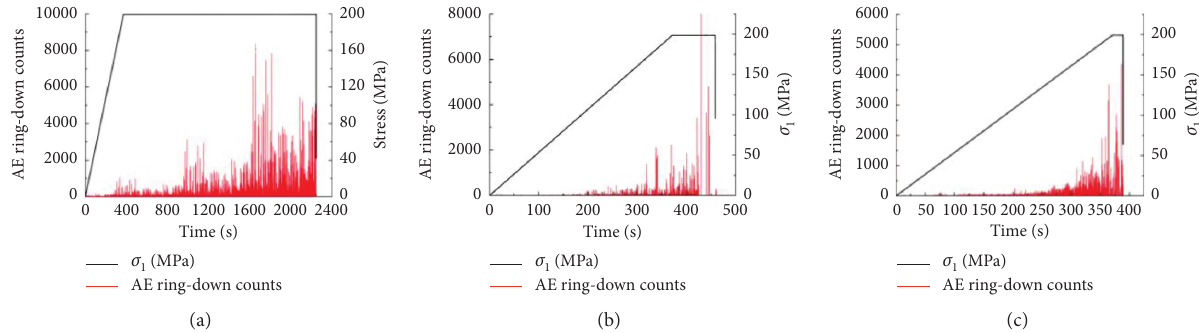
Figure 11: AE characteristics of granite under different confining pressure unloading rates. (a) v � 0.002 MPa/s. (b) v � 0.02 MPa/s. (c) v � 0.2 MPa/s.